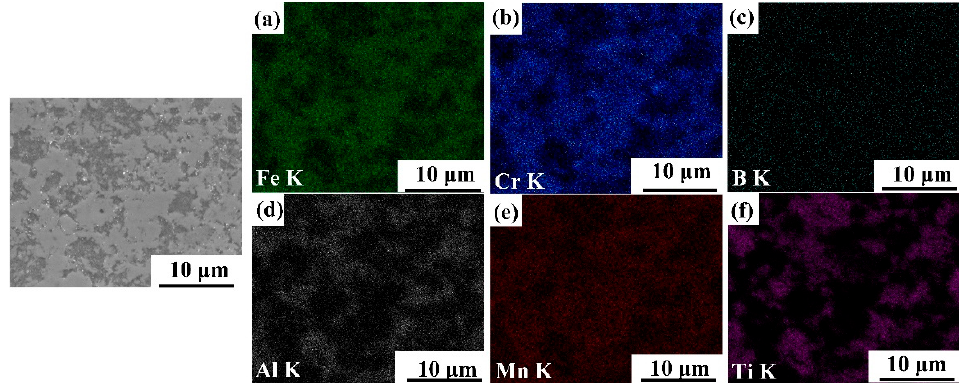
Figure 5. SEM image of 25 vol.%TiB 2 /Fe-15Cr-10Mn-5Al composite and elemental maps showing the distribution of ( a ) Fe, ( b ) Cr, ( c ) B, ( d ) Al, ( e ) Mn, and ( f ) Ti.